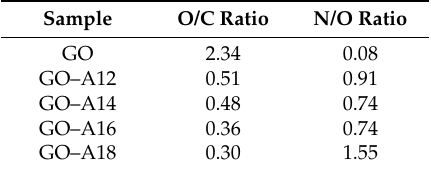
Table 2. Survey scan results for functionalized GO samples.